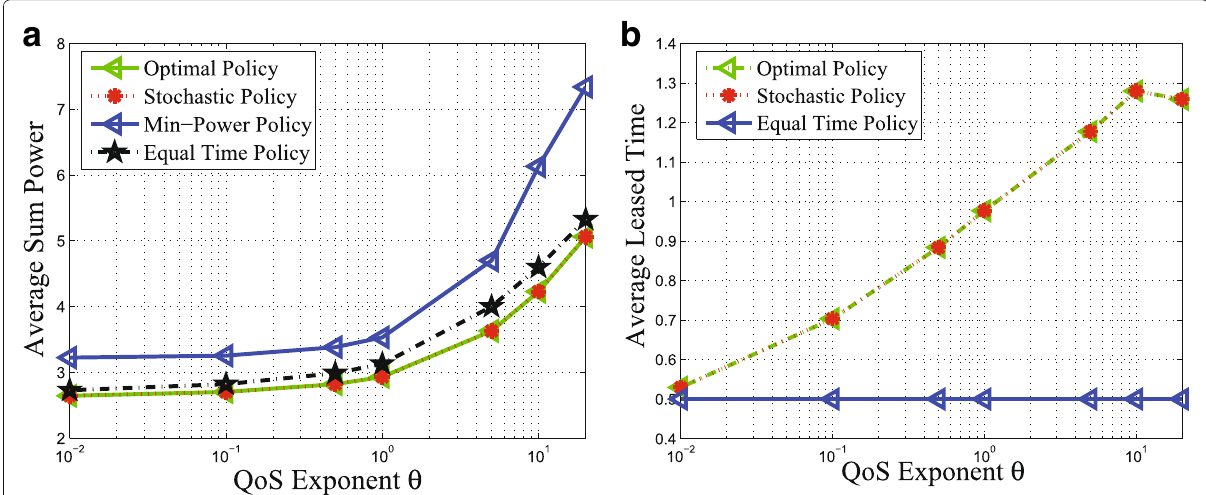
Fig. 5 a , b Average sum power and leased time versus delay QoS exponent θ with AF relay protocol when { ω 1 = 0.8, ω 2 = 0.2 } is